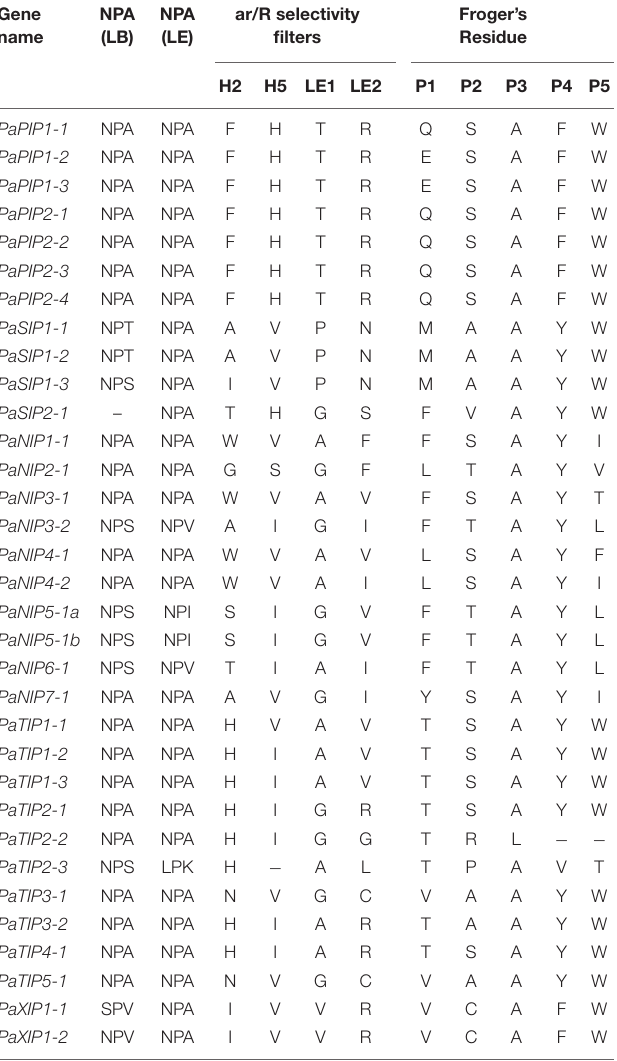
TABLE 2 | Amino acid composition of the NPA motifs, ar/R selectivity filter, and Froger’s residues of PaAQP